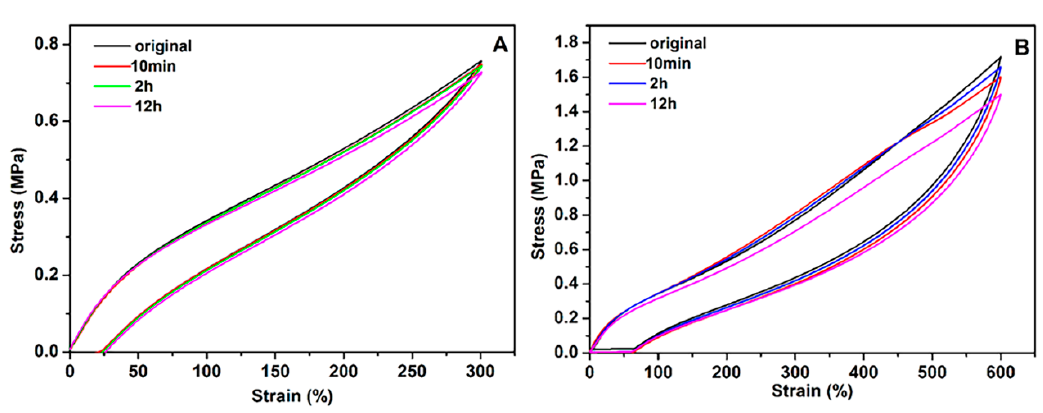
Figure 9. Tensile loading–unloading cycle curves of TA30–PU(S) hydrogel for different soaking times in distilled water: ( A ) at strain of 300%; ( B ) at strain of 600%.